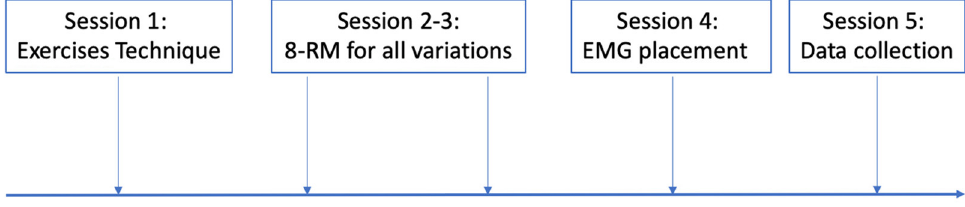
Figure 1. The study